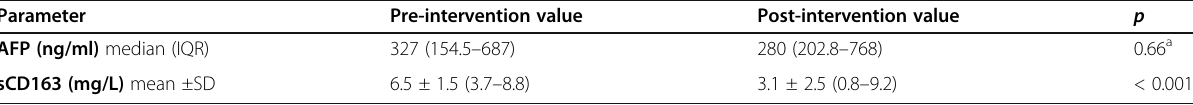
Table 4 Pre- and post-intervention values of AFP and sCD163 in all treated HCC cases ( n =36)